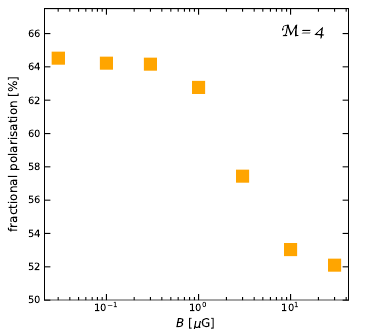
Figure 1. Left panel: Average fractional polarisation of the model relic as a function of magnetic field strength. The emission has been computed for a Mach number M = 4 and a redshift of z = 0.1. The fractional polarisation gives the luminosity weighted average including the entire downstream emission. For low magnetic fields ( B (cid:28) B CMB ) the fractional polarisation is about 12% higher than for high magnetic fields ( B (cid:29) B CMB ). The scatter of data points is due to the Monte Carlo approach of the simulation. Right panel: The fractional polarisation as a function of Mach number. The analysis includes the dependence of the emissivity on the Mach number beside the compression of the magnetic field at the shock front. The fractional polarisation has been computed for an upstream magnetic field strength of B = 1 µ G (blue) and B = 10 µ G